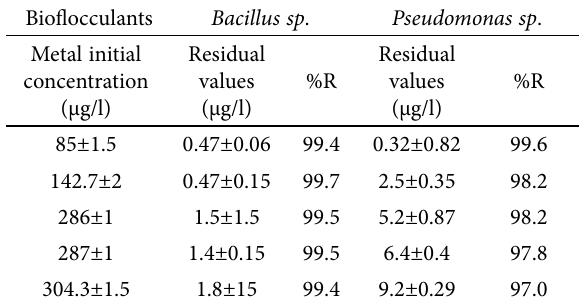
Table 1. The efficiency of bio-flocculants of Bacillus sp. versus Pseudomonas sp. for removal of Lead (Pb 2+ )